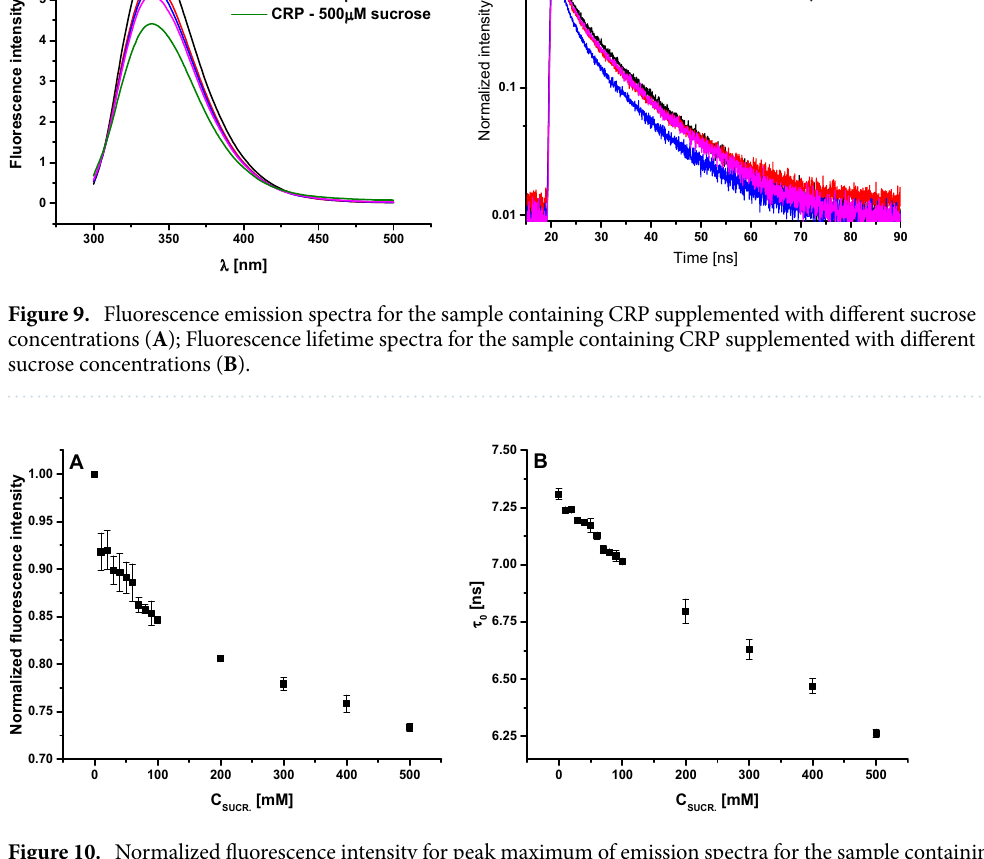
Figure 10. Normalized fluorescence intensity for peak maximum of emission spectra for the sample containing CRP supplemented with different sucrose concentrations ( A ); Fluorescence lifetime variation for the sample containing CRP supplemented with different sucrose concentrations ( B